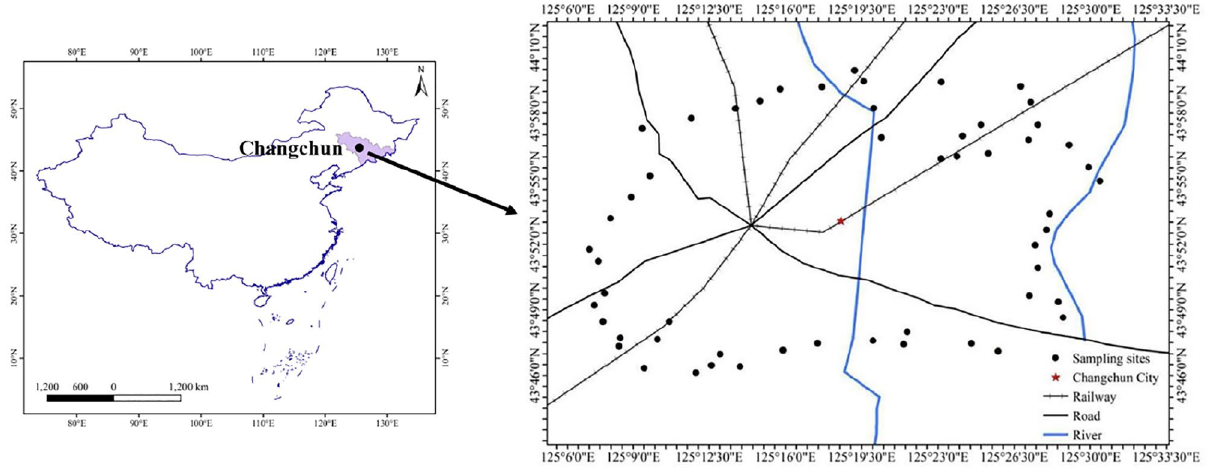
Figure 1. Study area and soil sampling